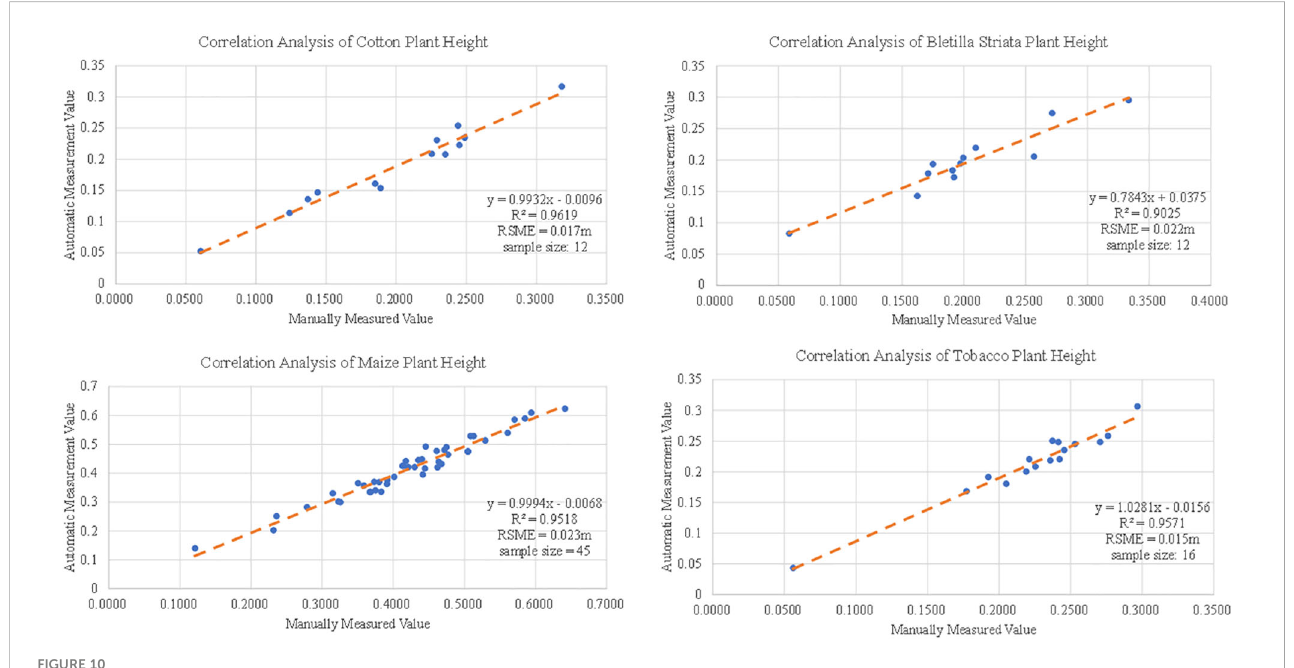
FIGURE 10 Correlation analysis of tobacco, potato, maize and Bletilla striata plant height data.